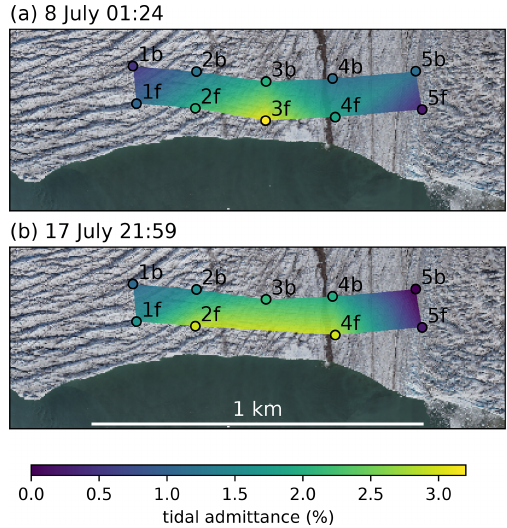
Figure 11. GPS-derived tidal admittance (range in vertical position as percentage of the tidal range) for two dates. Tidal admittance is interpolated linearly between the stations for the sake of visualiza- tion. Background UAV-derived ortho-images are from 15 July